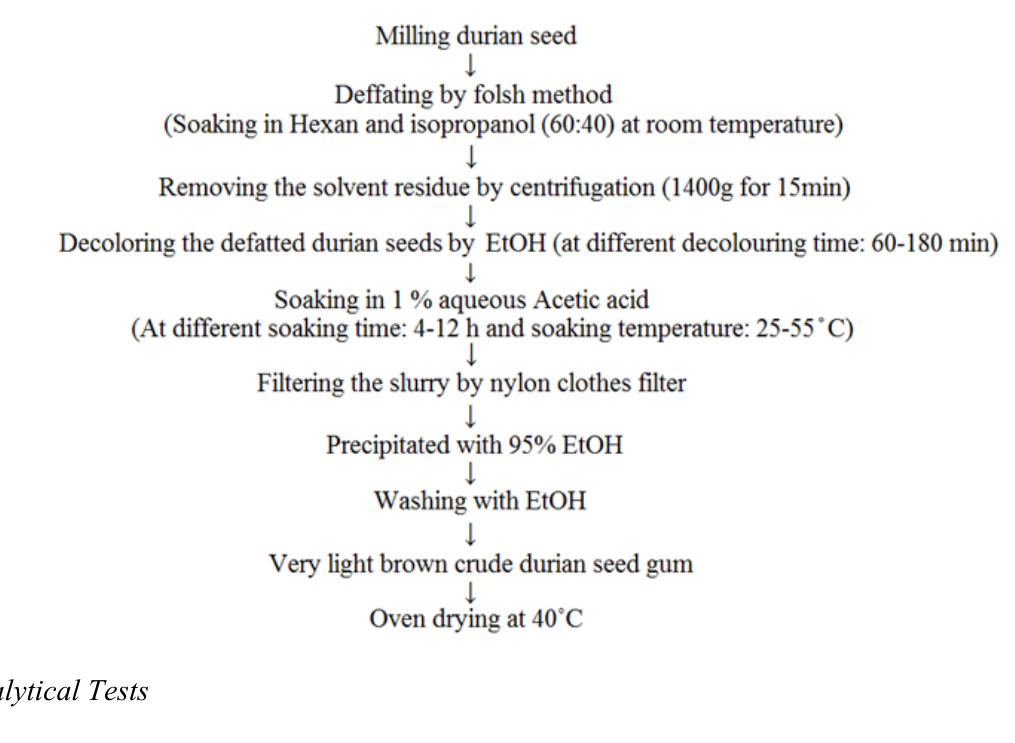
Figure 6. Flow chart of chemical extraction of durian seed gum